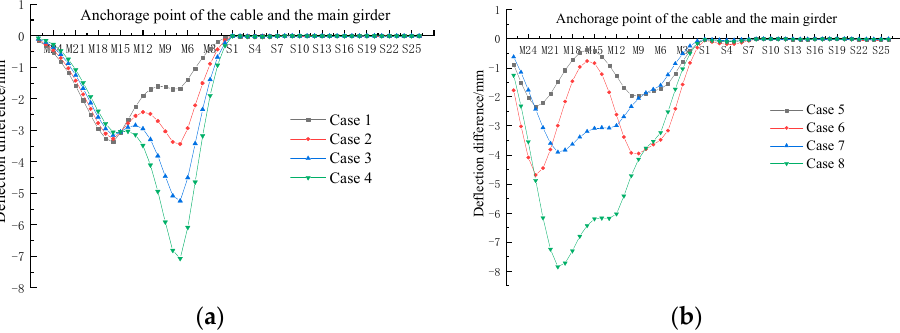
Figure 10. The distribution curves of the deflection difference of the girder before and after the cable damaged:( a ) Double-cable damage; ( b ) Three-cable damage.